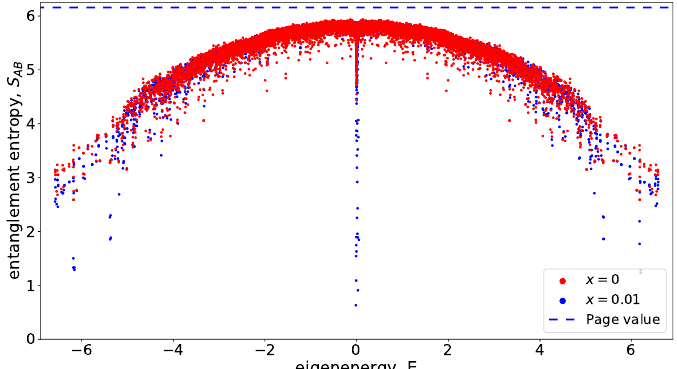
Figure 17: Bipartite entanglement entropy of eigenstates as a function of their eigenenergy, for a large Hilbert space fragment of the model (16) on the 6 × 6 lattice with p.b.c., for (red) x = 0, (blue) x = 0.01. Dashed line: Page value for this frag- ≈ 6.16. With no disorder, the fragment appears thermalizing, since ment, S AB ,Page the entanglement entropy of eigenstates form an arc with high-entangled states in the middle of the spectrum (with some outlying states, which are nevertheless have